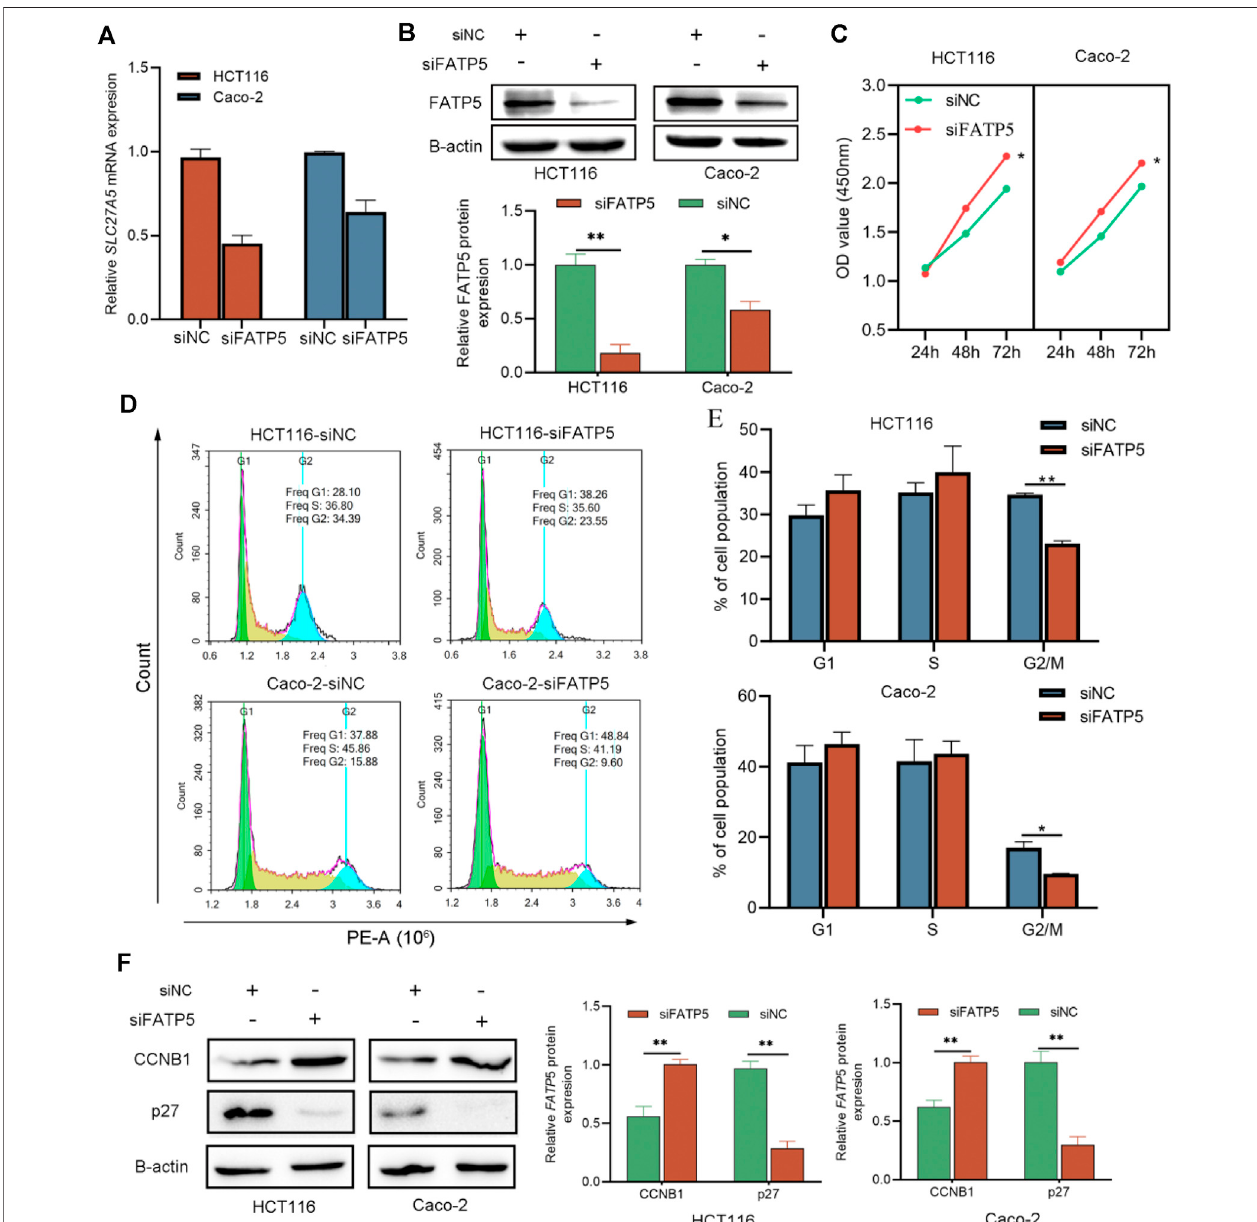
FIGURE 6 | siFATP5 facilitates cell growth and cell cycle G2/M phase transition. FATP5 expression was detected after transfection in CRC cells by qRT-PCR (A) and western blotting (B,C) CCK-8 assays were used to detect cell viability of CRC cells after transfection. (D,E) Flow cytometric analysis was used to detect cell cycle distribution of CRC cells after transfection. (F) The expression of cycle-related protein. * p < 0.05, ** p <